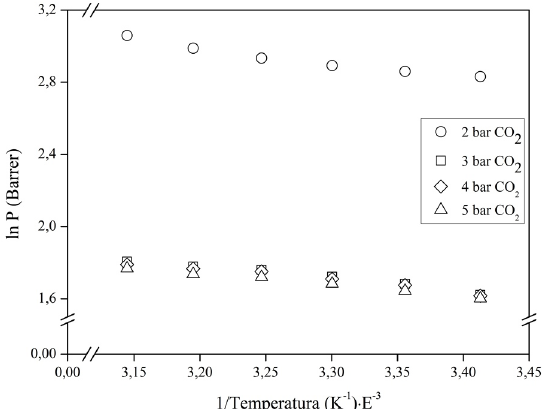
as a temperature Figure 5 - Permeability predicted by the Dual-mode model in 2 PSf membranes for CO permeation at 2